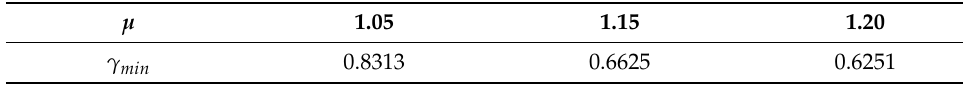
Table 1. Comparison of γ min with different values µ